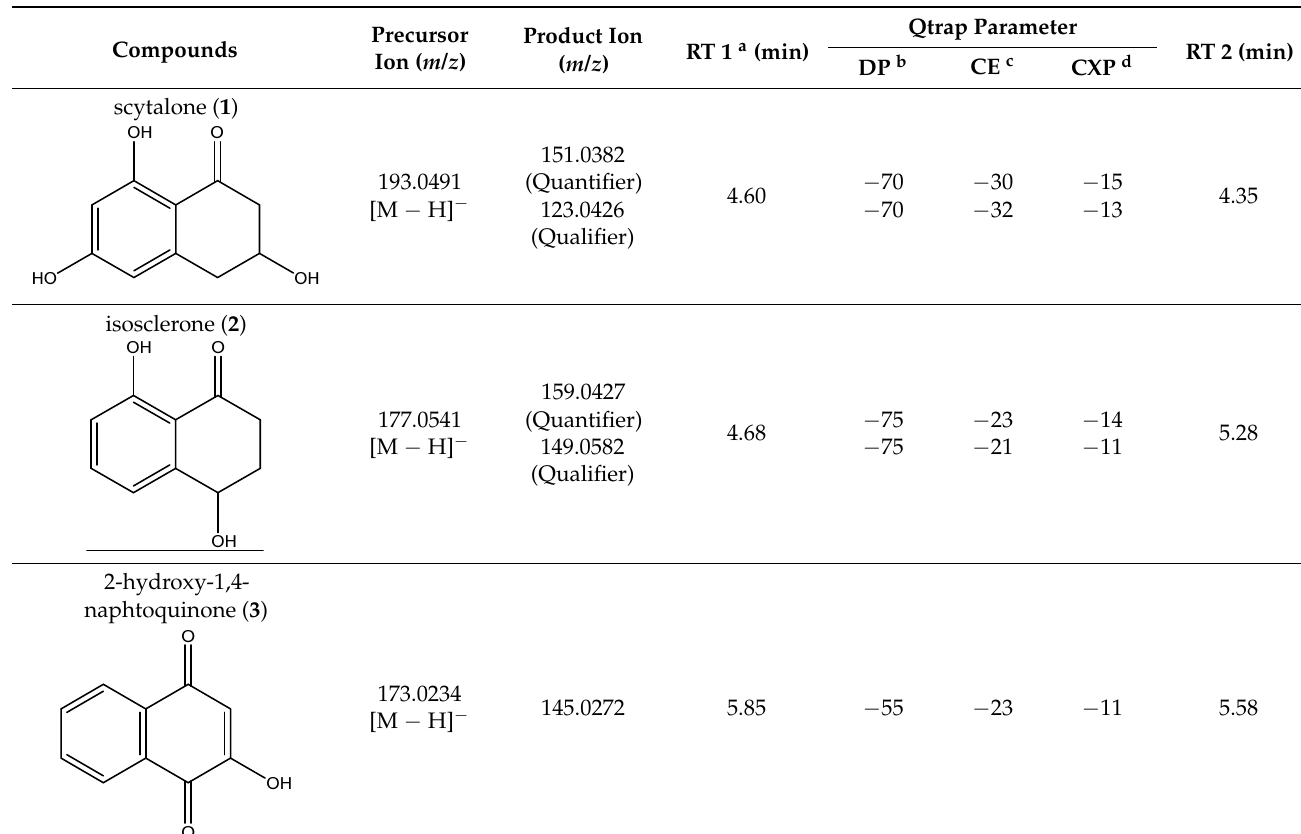
Table 1. Optimized Q1 mass, transitions, and parameters for LC-MS/MS analysis. Compounds